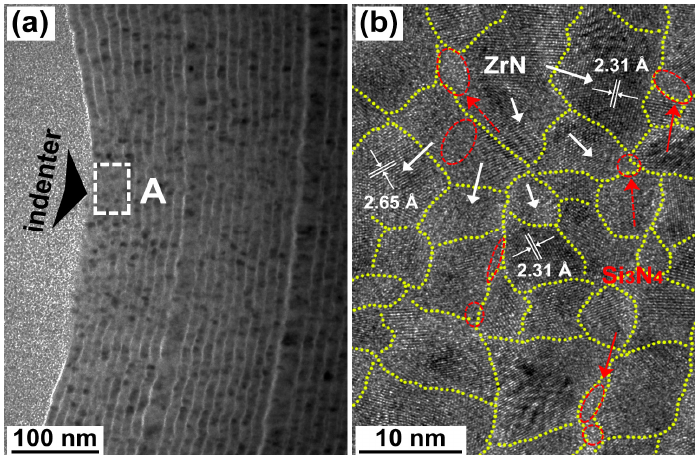
Figure 5. ( a ) The TEM image of the deformed zone just underneath the indentation; ( b ) shows a HRTEM image of framed region A.